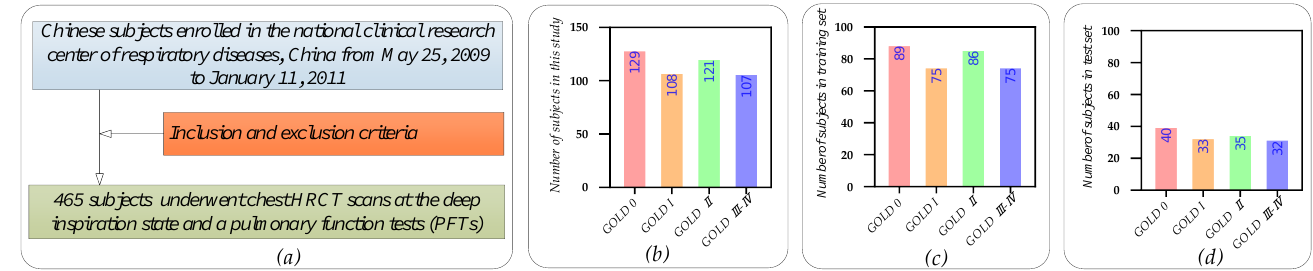
Figure 1. The participants ’ selection flow diagram and GOLD distribution of the participants in this study. ( a ) The participants ’ selection flow diagram; ( b ) GOLD distribution in our study cohort; ( c ) this study. ( a ) The participants’ selection flow diagram; ( b ) GOLD distribution in our study cohort; training set distribution; ( d ) test set distribution. ( c ) training set distribution; ( d ) test set